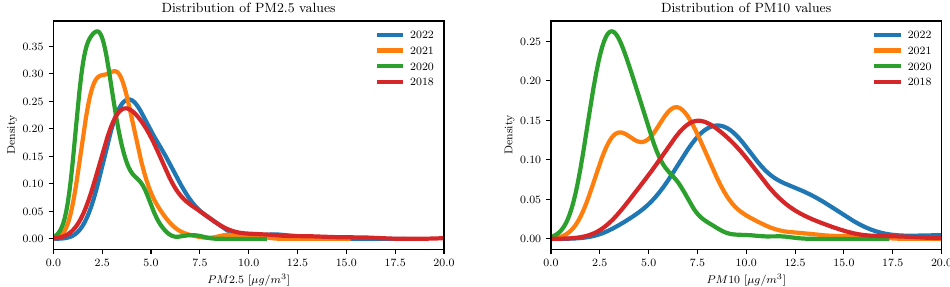
Figure 3. The distribution of PM2.5 ( left ) and PM10 ( right ) in May 2018, May 2020, May 2021, and May